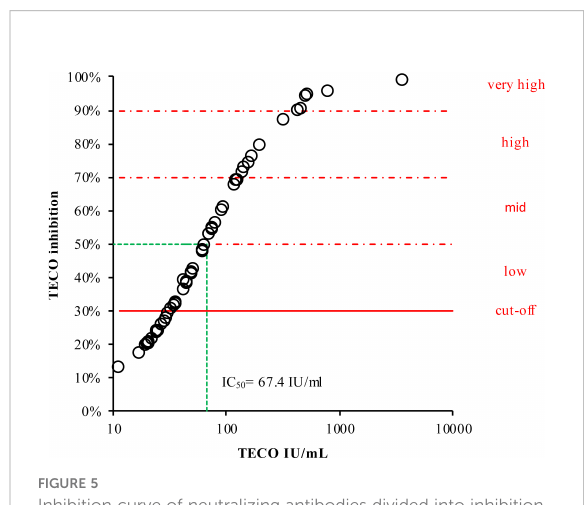
FIGURE 5 Inhibition curve of neutralizing antibodies divided into inhibition ef fi cacy groups dependent on respective measured antibody concentration. The cut-off is given as a continuous red line. For better visualization and estimation, the neutralizing potential was marked by gradual inhibition areas (dashed red lines). For classi fi cation of antibody titers (in %), according to their inhibition potency (IU/mL, derived from TECO neutralization assay), please also refer to Table 3. Green dashed line represents half-maximal inhibition (50%), corresponding to 67.4